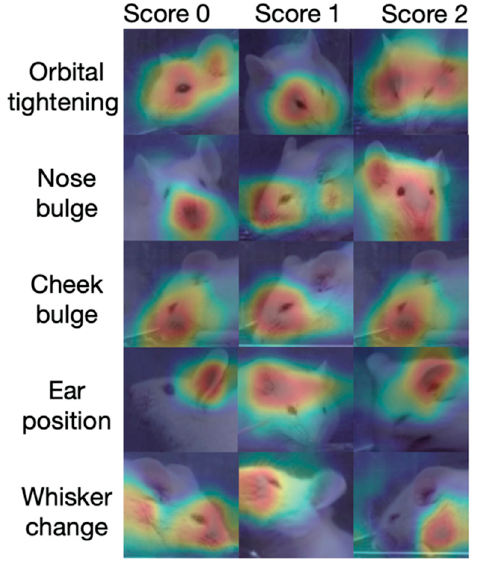
Figure 5. Heatmaps generated using the Grad-CAM method in the mouse facial images. Each image was obtained randomly from the dataset. The red areas represent salient areas that DeepMGS rely on to infer each MGS action unit score. The heatmaps reveal that DeepMGS focuses on the appropriate facial areas when scoring corresponding action units.